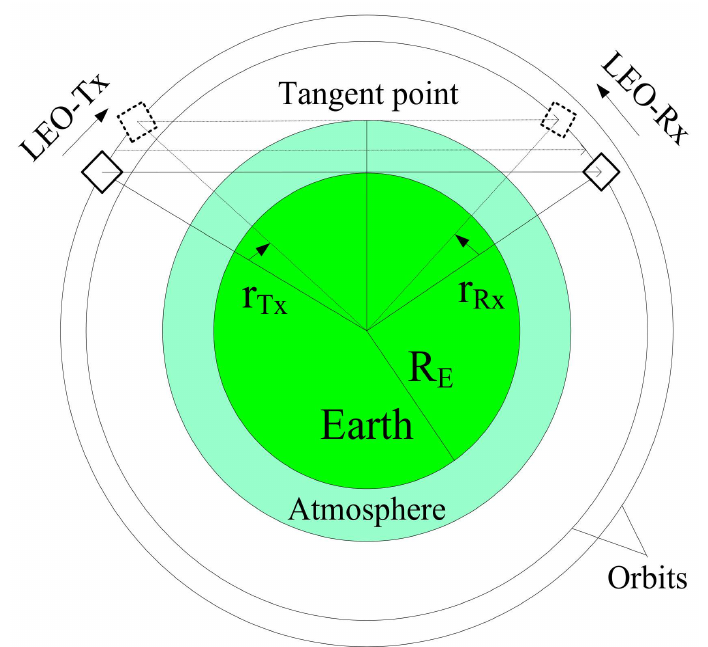
Figure 1. Occultation geometry between one LEO transmitting satellite (Tx) and one LEO receiving satellite (Rx), schematically illustrating the signal ray path passing through the atmosphere and the tangent point of a rising occultation event. The solid-line squares and dotted-line squares represent the occultation event starting time (near-surface) and ending time (top-of-atmosphere) positions of the LEO-LEO satellite pair,